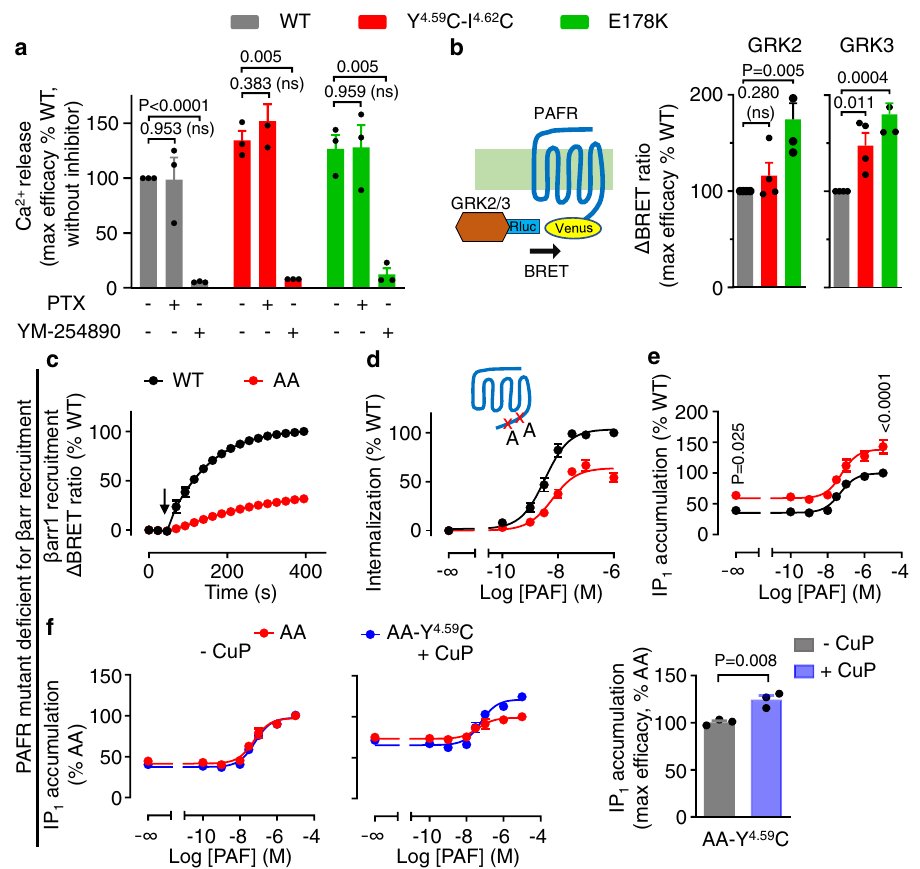
Fig. 6 | The increase of G protein coupling is not only due to the lack of β arr recruitment. a Intracellular Ca 2+ responses mediated by the indicated PAF recep- torsuponstimulationwithPAF(1 μ M),afterorwithouttreatmentwithPTX(100ng/ ml) or YM-254890 (100nM). The indicated maximal ef fi cacy is from the dose – response in Supplementary Fig. 13a. b Recruitment of GRK2-Rluc or GRK3- Rluc to the Flag-tagged PAFR-Venus upon stimulation with PAF (1 μ M). The indi- catedmaximalef fi cacyisfromSupplementaryFig.14aandd. c KineticsoftheBRET signal between PAFR-Venus and β arr1-Rluc after the injection of PAF (1 μ M, arrow)